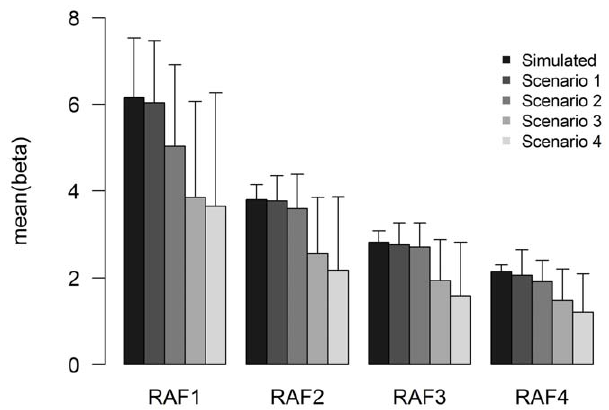
Figure 2. Comparison of effect size and standard error estimated by meta-analysis to simulated true values. The simulated QTLs explain 2.0% of the total trait variance.